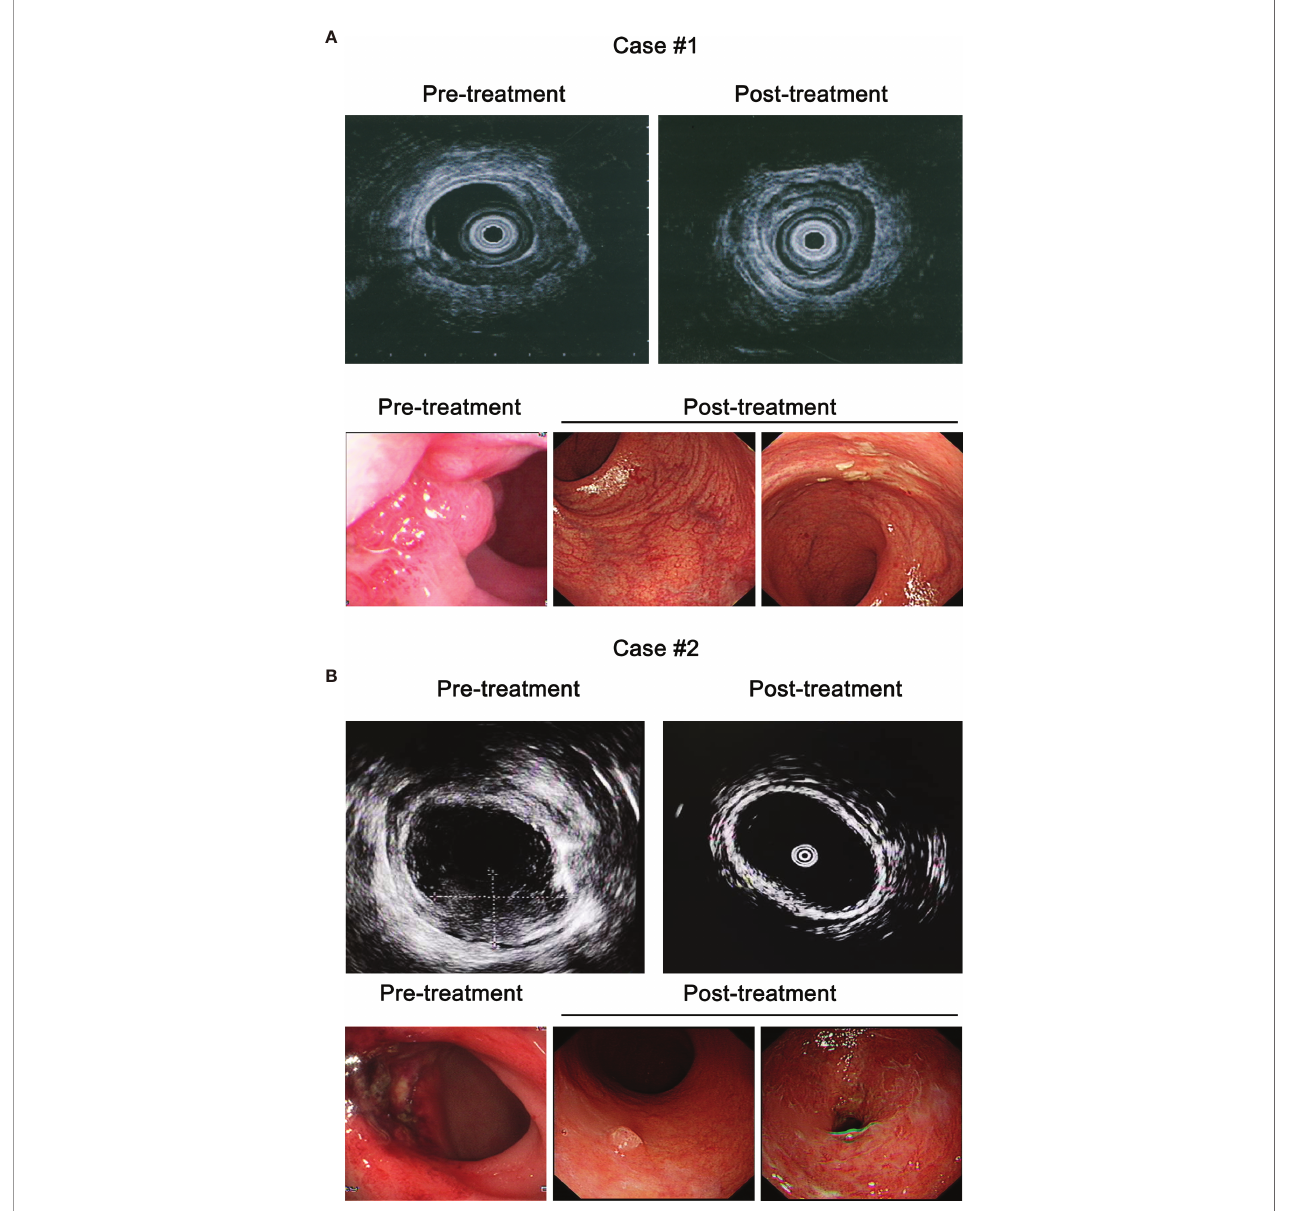
FIGURE 4 | Clinical images of representative patients in the current study. (A) Pre- and post-treatment colonoscopic endoanal ultrasound scanning (EUS, upper panel) and colonoscopy (lower panel) images of case #1 with T2 tumor. (B) Pre- and post-treatment EUS (upper panel) and colonoscopy (lower panel) images of case #2 with T3